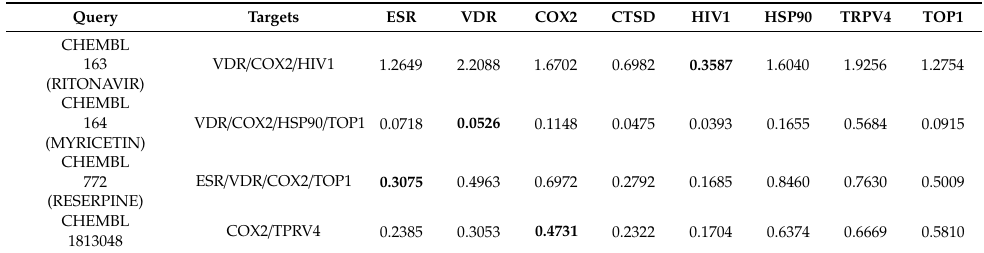
Table 3. K–L divergence of ligands shared with eight target classes